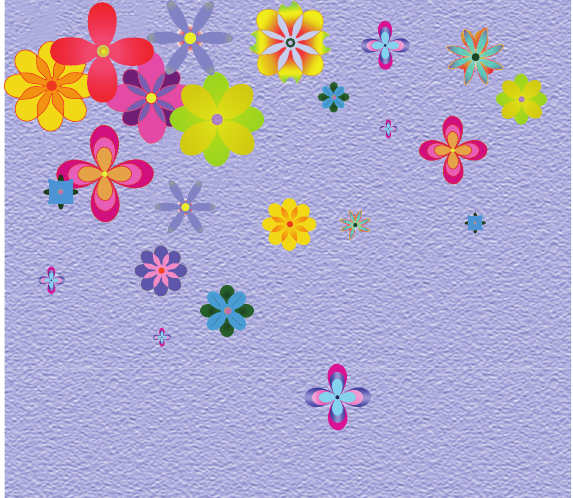
Figure 8: Generalized offset surface with the fixed offset direction.